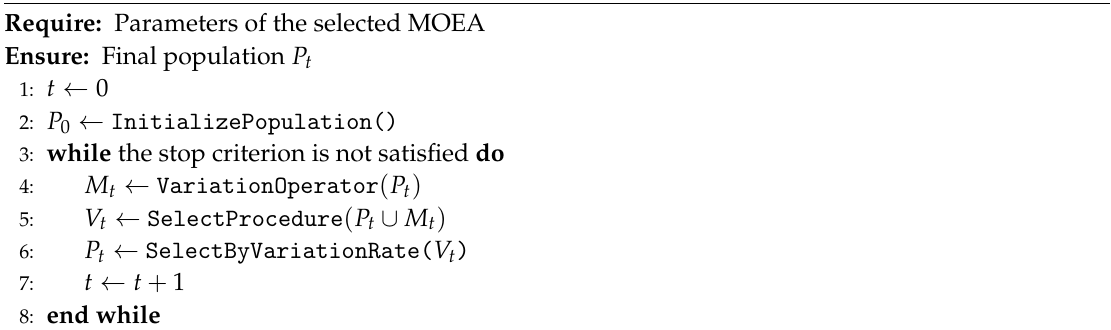
Algorithm 1 Framework to include the Average Distance in Variables within any MOEA Require: Parameters of the selected